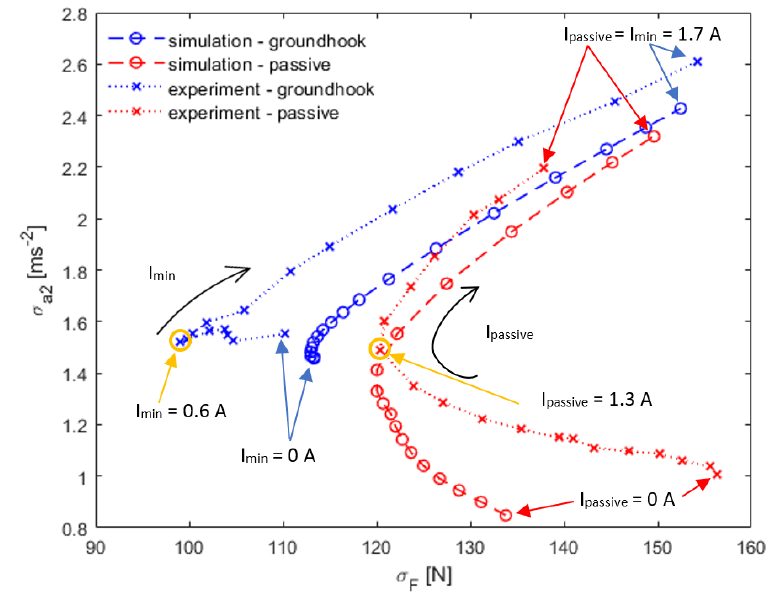
Figure 10. Comparison of the Groundhook algorithm and passive mode (circles indicate the best RMS adhesion force).